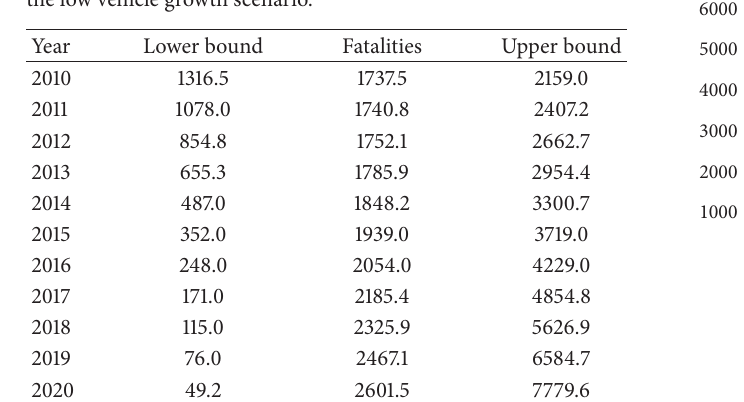
Table5:ForecastedabsolutenumbersofCambodianfatalitiesinthe